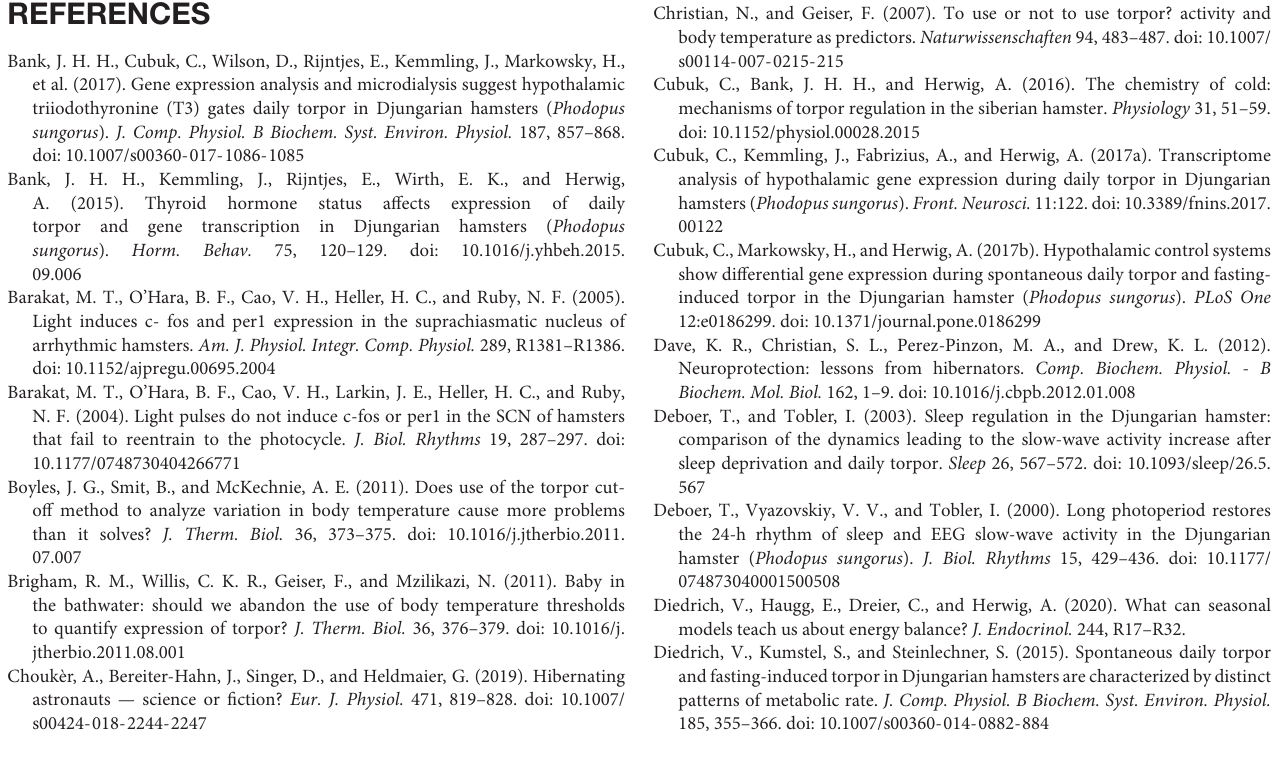
experimental week per torpor incidence group ( Table 3 ).